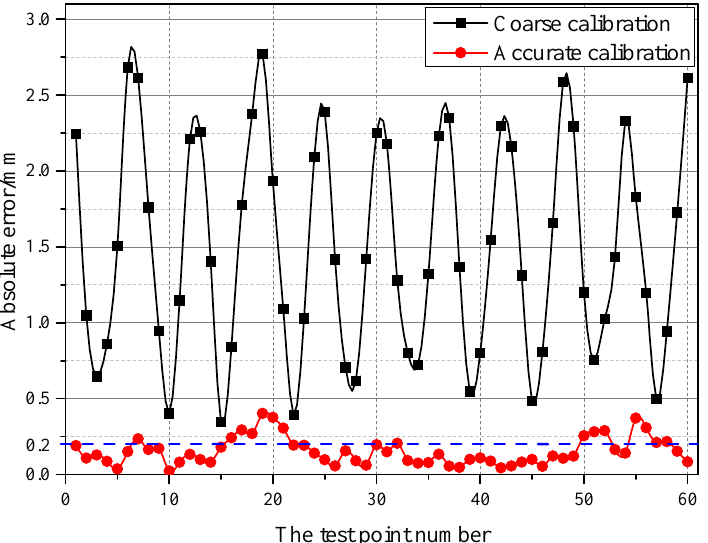
Figure 5. Comparison of the absolute error of the measurement results of the visual system after coarse and accurate